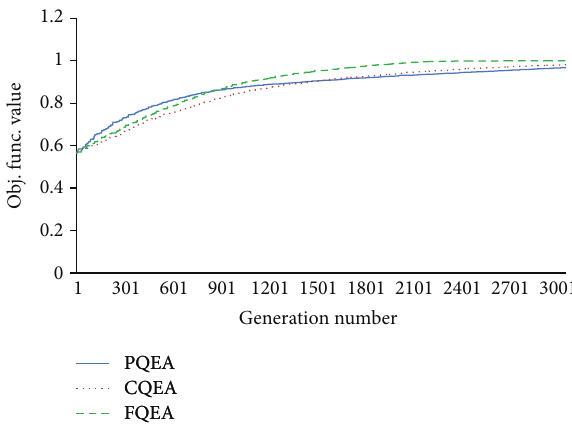
Figure 15: Convergence graph of PQEA, CQEA, and FQEA on 𝑃 - PEAKS problem of size, 𝑁 , being 1000 and number of peaks, 𝑃 , being 50.